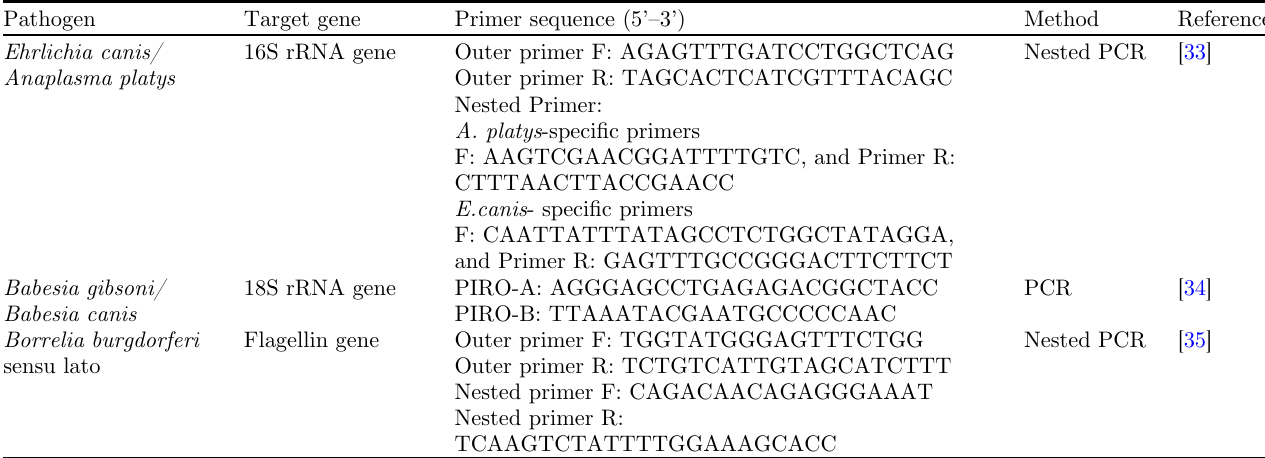
Table 1. Overview of the target gene, primer and PCR methods used for pathogen identi fi cation in sampled